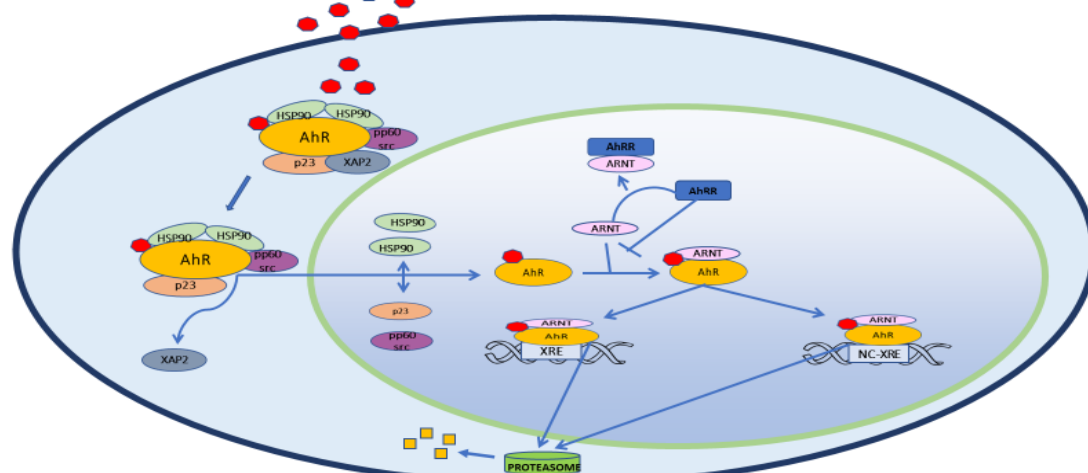
Figure 1. The Aryl hydrocarbon receptor (AhR) pathway. This transcription factor usually resides in the cytoplasm, where it associates with some inactivating molecules: two HSPs90s, one XAP2 or AIP, one HSP90 co-chaperone protein named p23, one pp60(c-src). Once it binds a ligand, XAP2 leaves the complex that moves to the nucleus. Here, the two HSP-90s, p23 and pp60-src drop AhR that binds to ARNT. This new complex is now ready to interact with XRE of genes like CYP1A1 , CYP1A2 , CYP1B1 and AHRR , usually containing the sequences 5’-GCGTG-3 (cid:48) or 5 (cid:48) -ACGTG-3 (cid:48) . AhR also targets NC-XREs, which bind AhR, while not containing the canonical consensus sequence. Just before the transcription starts, AhR moves from XREs, is translated out of the nucleus by XPO1 (not shown) and is degraded in the cytoplasm by 26S ubiquitin–proteasome. AhRR = Aryl Hydrocarbon Receptor Repressor; AIP = Immunophilin-like Ah Receptor-interacting protein); ARNT = Aryl Hydrocarbon Nuclear Translocator; CYP1A1 = Cytochrome P450 Family 1 Subfamily A Member 1; CYP1A2 = Cytochrome P450 Family 1 Subfamily A Member 2; CYP1B1 = Cytochrome P450 Family 1 Subfamily B Member 1; HSPs90 = Heat Shock Proteins 90; NC-XRE = Nonconsensus Response Element; p23 = Proteolytically Resistant 23-kDa protein; pp60(c-src) = Proto-oncogene tyrosine-protein kinase 60 (Sarcoma); XAP2 = Hepatitis B virus X-Associated Protein 2; XPO1 = Exportin 1; XRE = Xenobiotic Response